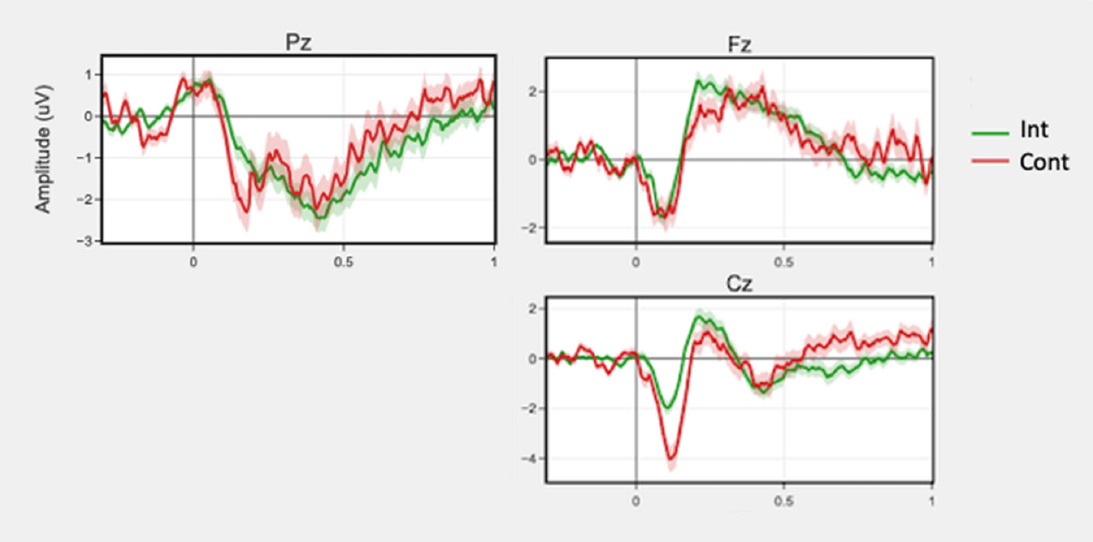
Figure 4. Mean ERN waveforms for correct and incorrect trials across sessions by group for channels Fz, Pz, and Cz. Time 0 represents response onset. Shaded regions around the lines represent +/ − SEM.